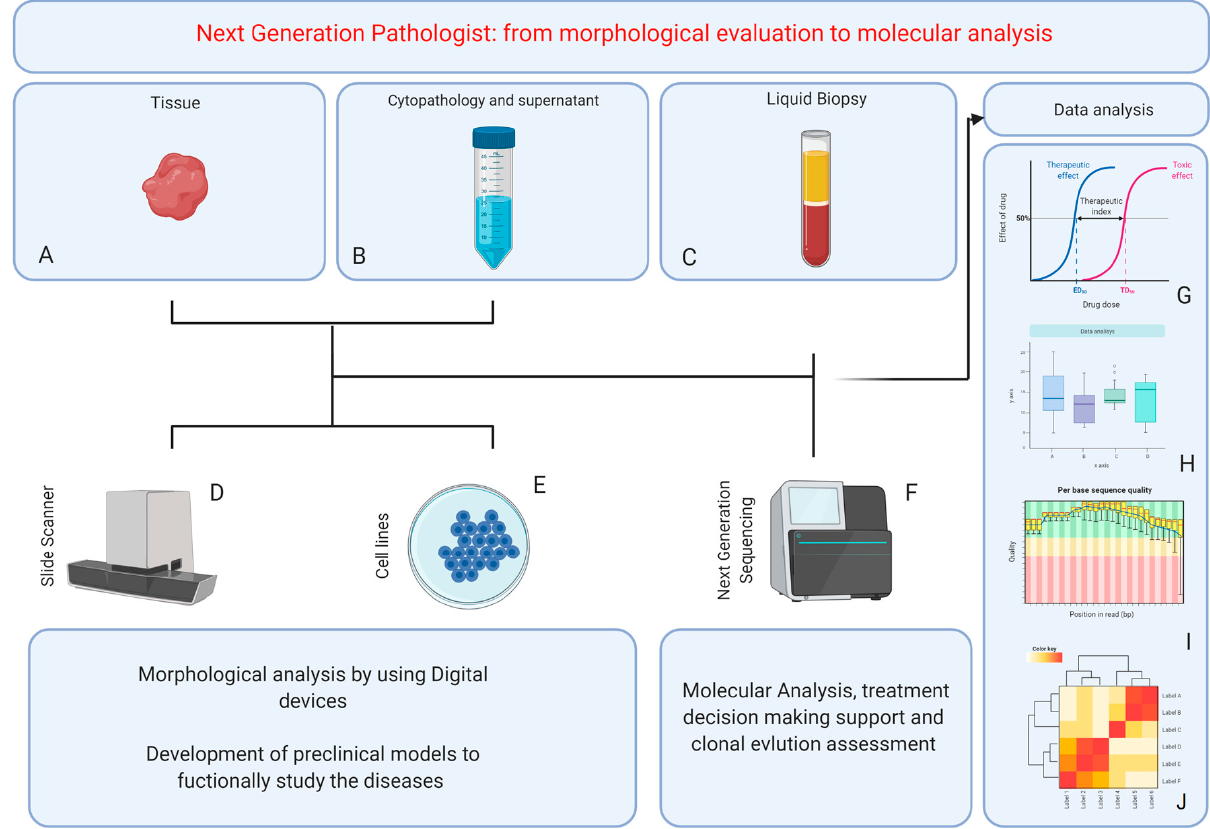
Figure 1. Schematic representation of next-generation pathologist area of expertise, from tissue management and analysis ( A ), including cytological samples and body fluids ( B , C ), to fully morpho-molecular characterization ( D – F ) of patients. ( G – J ): schematic representation of integrative data analysis among drug dose–response ( G ), cell line expression profile ( H ) and next-generation results on DNA ( I ) and RNA ( J ). Credit by